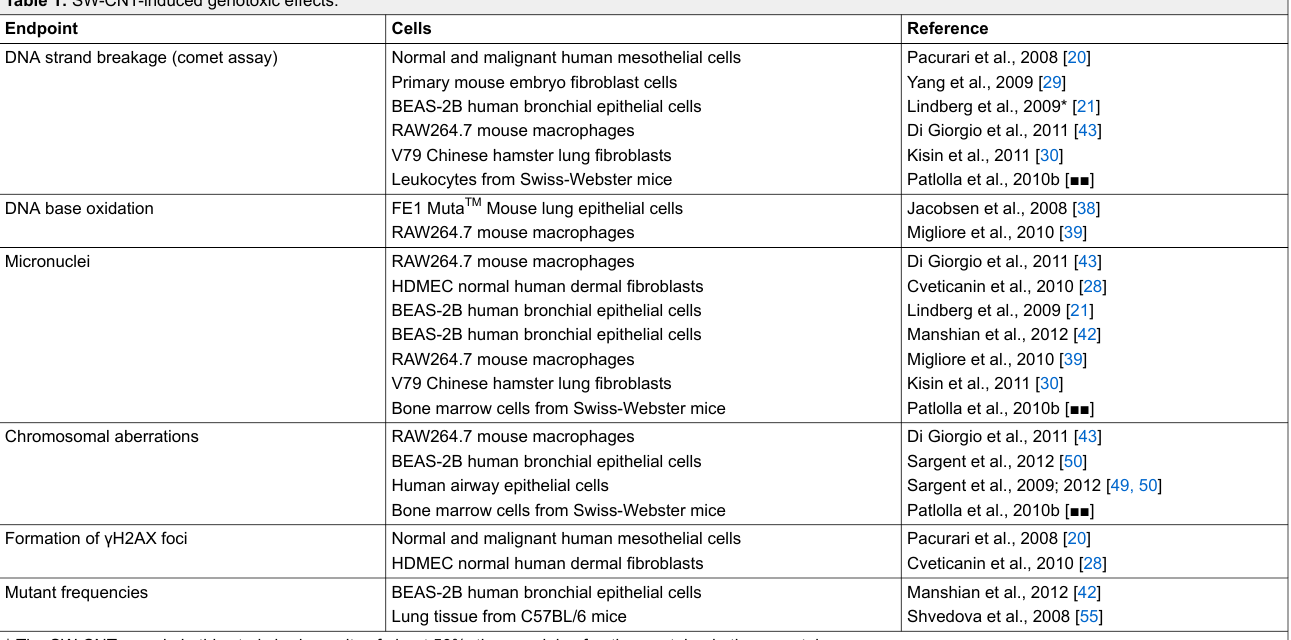
Table 1: SW-CNT-induced genotoxic effects. Endpoint Cells Reference DNA strand breakage (comet assay)